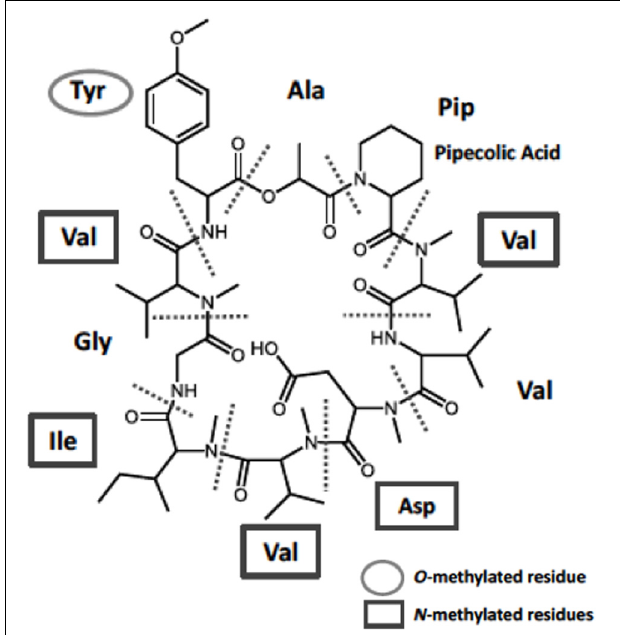
FIGURE 1 | Chemical structure of KK-1 identified in the fungus Curvularia clavata . Constituent amino-acid units are separated by the dotted lines: Pip, pipecolic acid residue (non-proteinogenic amino acid); Val, valine residue; Asp, aspartic acid residue; Ile, isoleucine residue; Gly, glycine residue; Tyr, tyrosine